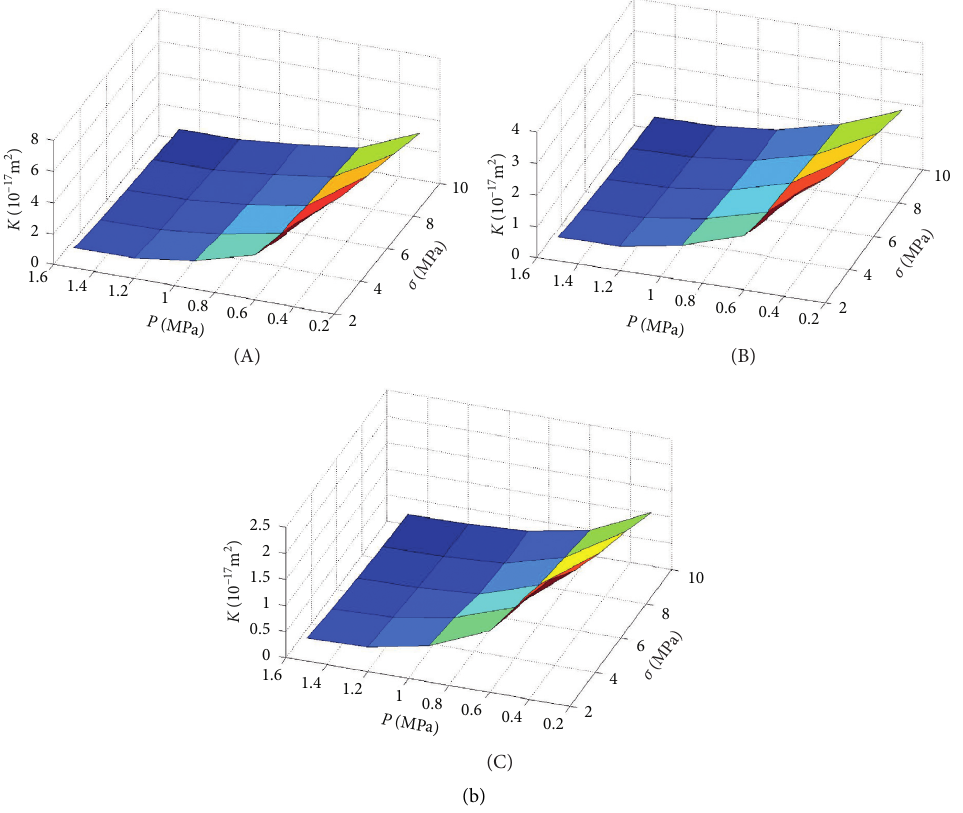
Figure 6: The percolation rate surface of coal. (a) k- T-σ graphs of coal samples. (A) p � 0.3 MPa. (B) p � 0.6MPa. (C) p � 0.9MPa. (b) k- p-σ graphs of coal samples. (A) T � 30 ° C. (B) T � 50 ° C. (C) T � 70 °